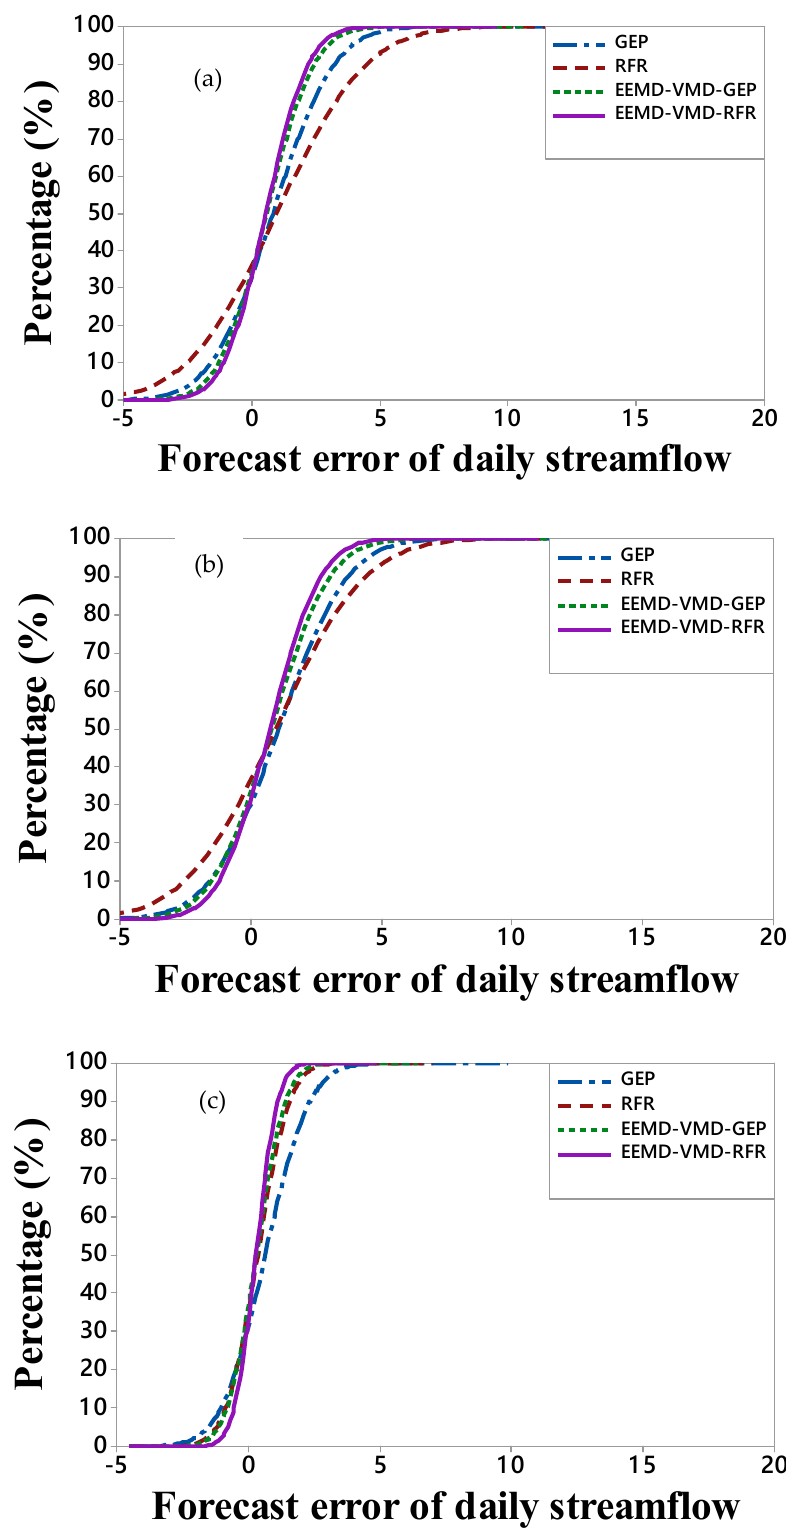
Figure 14. Empirical cumulative distribution (ECDF) of the absolute forecasted error |FE| (m 3 /s) for the EEMD-VMD-RFR model compared to the other models at ( a ) Siira, ( b ) Bilghan, and ( c ) Gachsar stations in the validation phase.